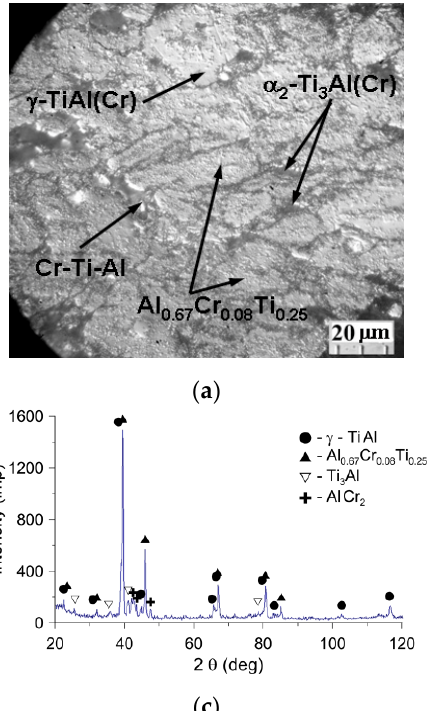
propagating high-temperature synthesis (MASHS) [23]. The preliminary mechanical pro-